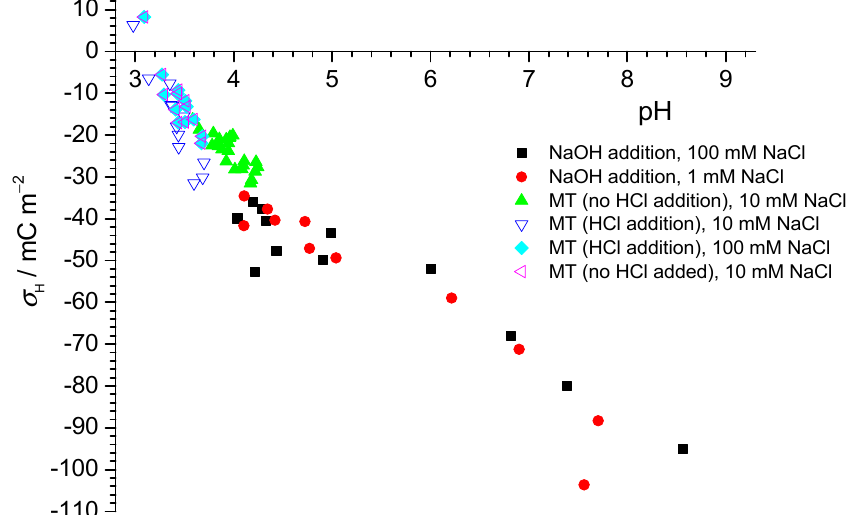
Figure 1. Proton-related surface charge density of polytetrafluorethylene (PTFE)-B-200 obtained by mass titrations ( ▲ , , ♦ , ) and independent potentiometric (batch) titrations ( ■, ● ) in sodium chloride aqueous solution, θ = 25 °C.